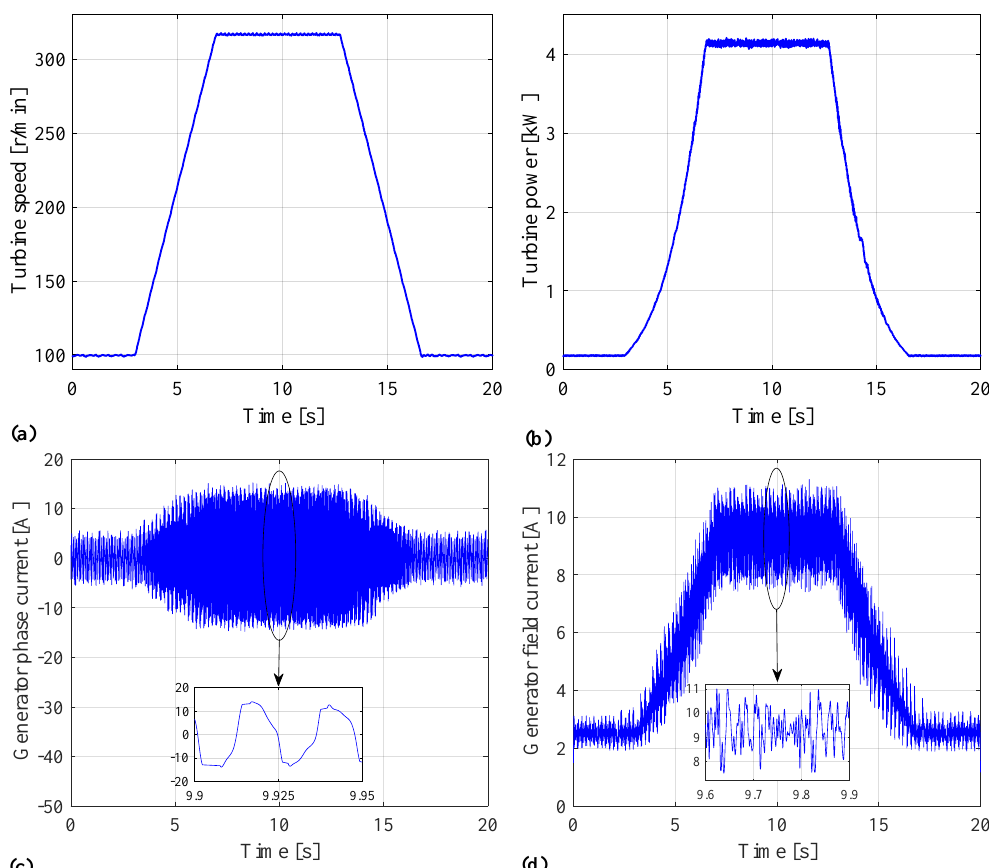
Figure 25. Measured step responses ( a ) turbine speed, ( b ) turbine power, ( c ) generator phase current, and ( d ) generator field current versus